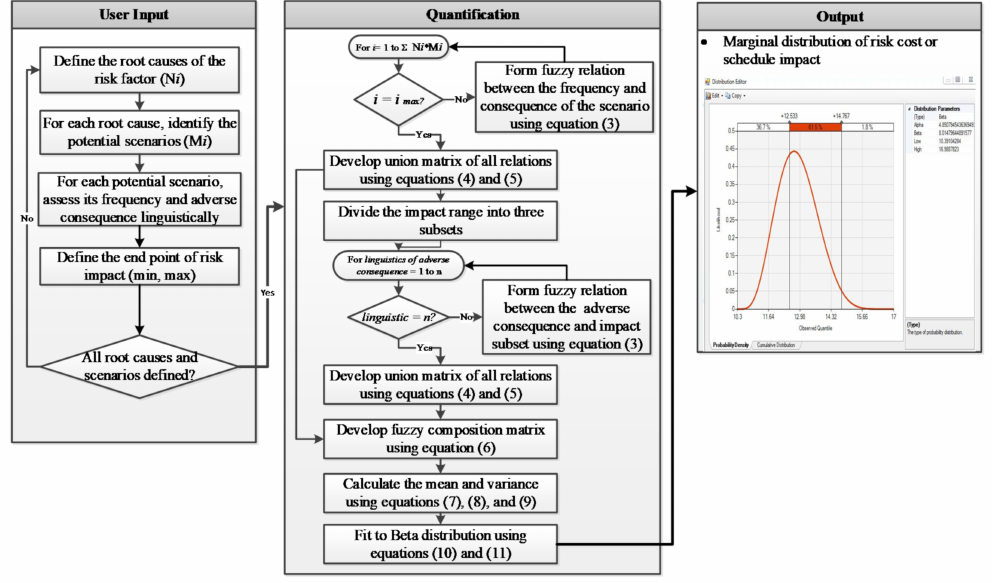
Figure 4. Quantification steps for marginal